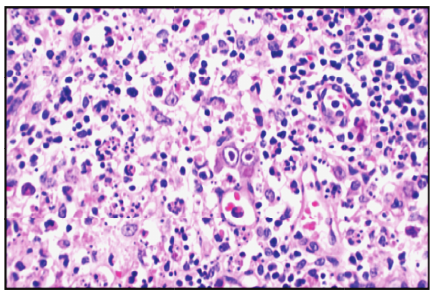
Figure 3: Viral inclusion containing cells seen in lymph node (magnification × 400).